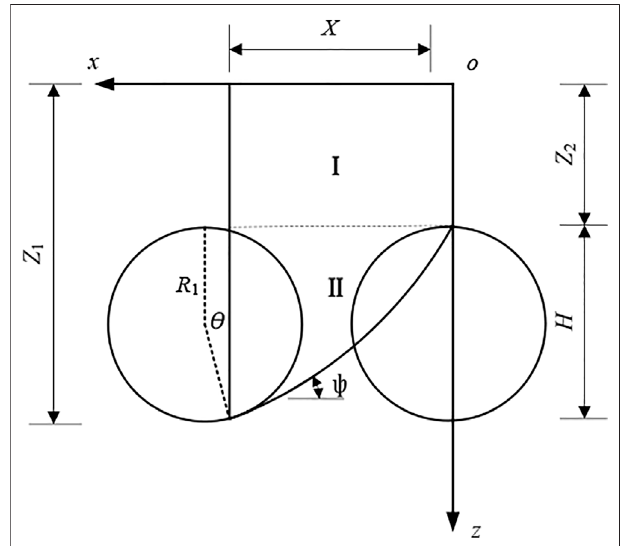
FIGURE 2 | Cycloidal failure